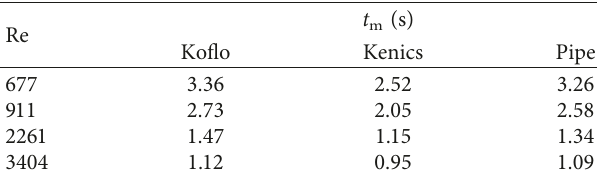
Figure 26: The effective mechanical energy destruction: (a) crystal-crystal collisions; (b) crystal-static inserts collisions. Table 8: The collection of t m values.